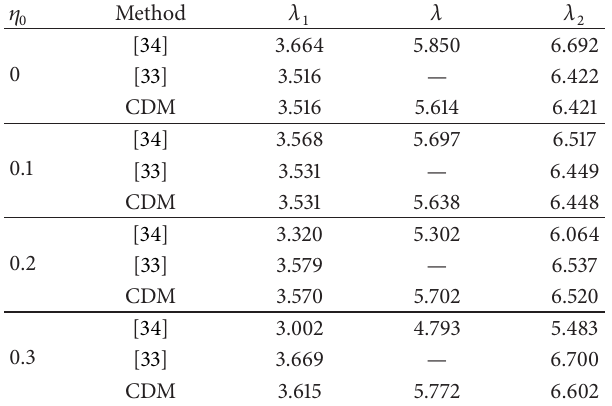
Table 4: Numerical comparison among R-R, R-S, and CDM of clamped-simply supported DWCNTs: in columns 3 and 5, the first two dimensionless fundamental frequencies 𝜆 1 and 𝜆 2 , with 𝑐 12 = 0 , are reported, while in column 4, the first frequency 𝜆 , with 𝑐 12 = 0.0694 TPa, is